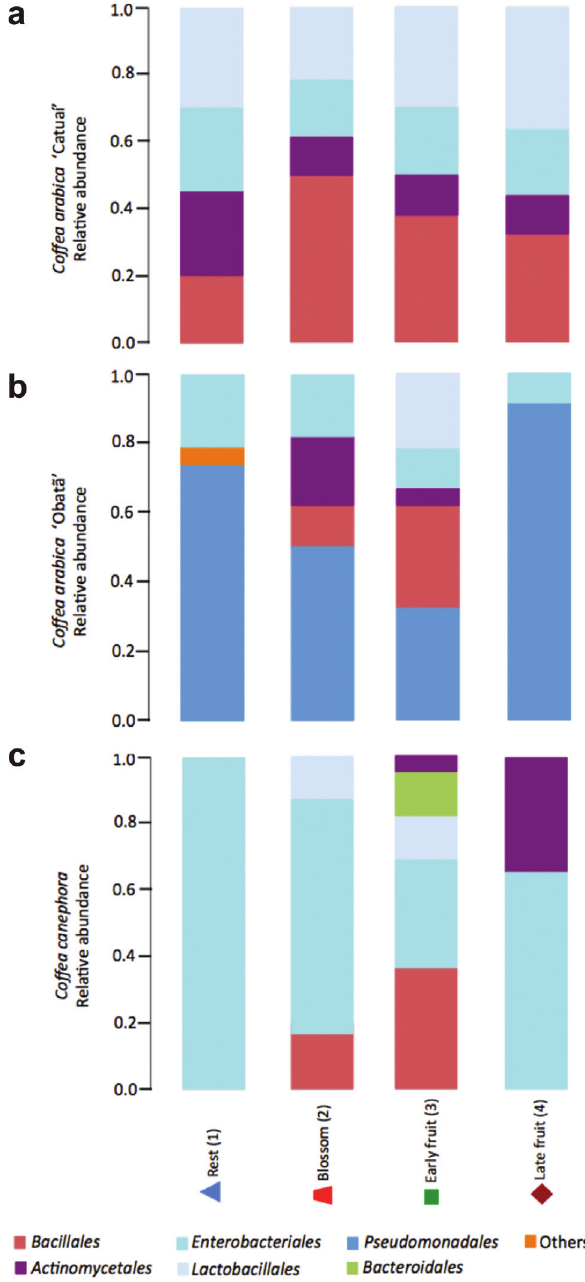
Figure 2 - Distribution of sequences (y-axis) corresponding to the prevail- ing orders in the three coffee genotypes at four different collection times (x-axis). Taxonomic classification of leaf-associated bacterial sequences in coffee samples according to the RDP classifier (http://rdp.cme.msu.edu). a) C. arabica ‘Catuaí’, b) C. arabica ‘Obatã’, and c) C. Canephora